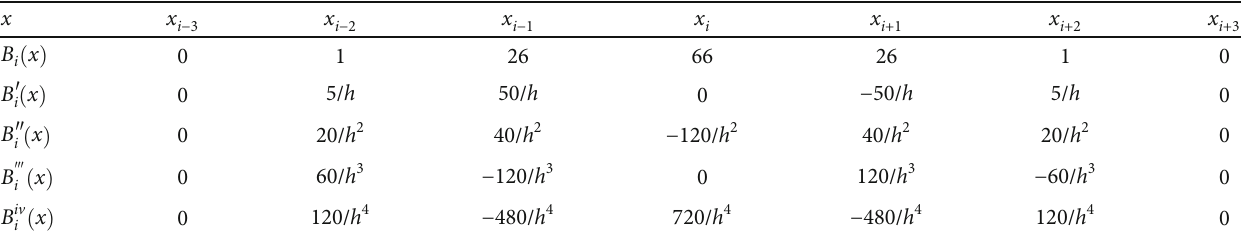
ð x Þ and its derivatives at the nodes i